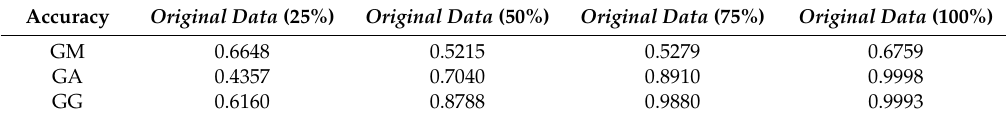
Table 2. The accuracy of RUL prognostics with the energy feature.